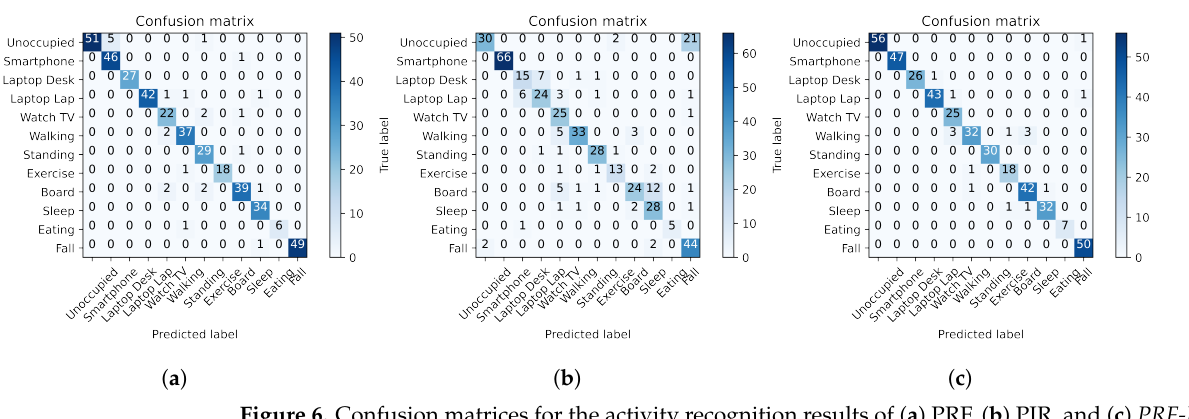
Figure 6. Confusion matrices for the activity recognition results of ( a ) PRF, ( b ) PIR, and ( c ) PRF-PIR sensor